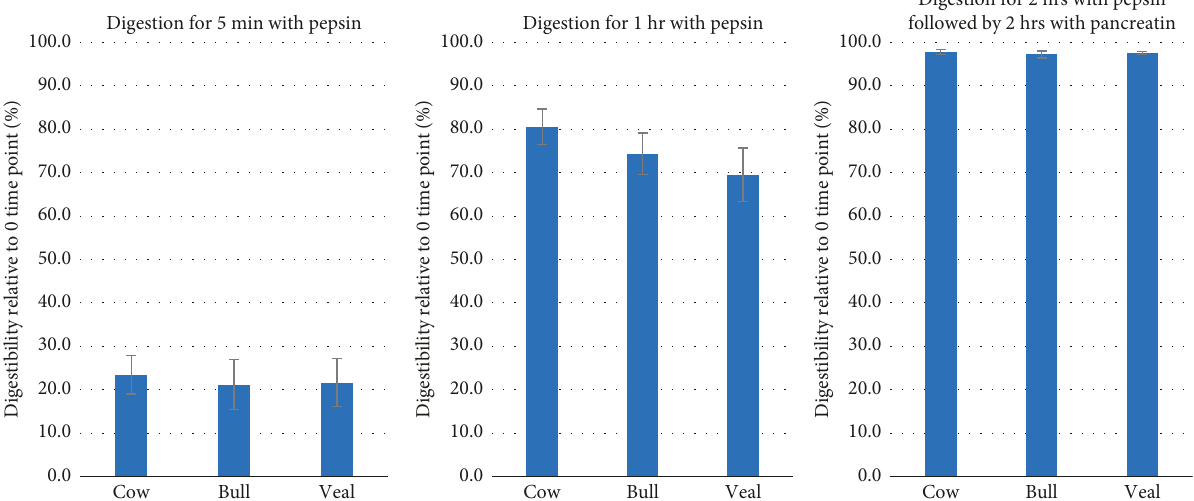
Figure 3: Experiment 1: the relative digestibility (see methods) of cooked semimembranosus from cow (C), bull (B), and calf (veal, V) at 5min and one hour of gastric phase and two hours of intestinal phase. Results for the pooled samples from 7 animals per age are presented as